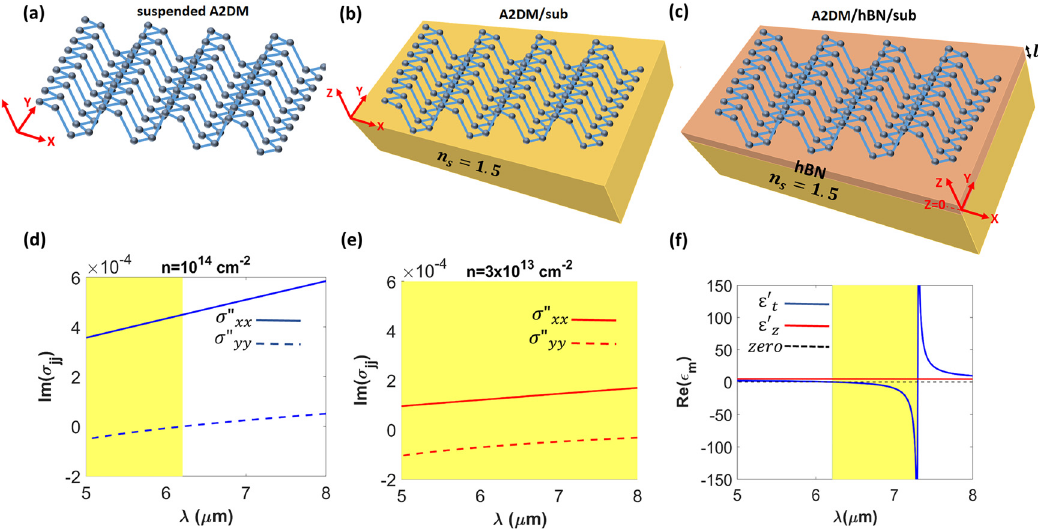
Figure 1: [(a) – (c)] Suspended A2DM sheet, A2DM/sub structure, and A2DM/hBN/sub structure; for illustrative purposes, in panels [(a) – (c)] a BP layer with puckered structure represents the A2DM sheet; (d) and (e) imaginary part of the xx (solid curves) and yy (dashed curves) components of the optical conductivity tensor of the considered A2DM for n (cid:1) 10 14 cm − 2 and n (cid:1) 3 × 10 13 cm − 2 ; (f) real part of the transversal (blue curve) and z (red curve) components of hBN permittivity where the extra dotted line indicates zero values of the permittivity; shaded regions in panels (d) – (f) highlight the hyperbolic